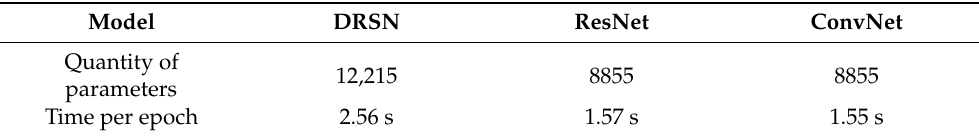
Table 8. The number of parameters and training time per epoch for DRSN, ResNet and ConvNet.